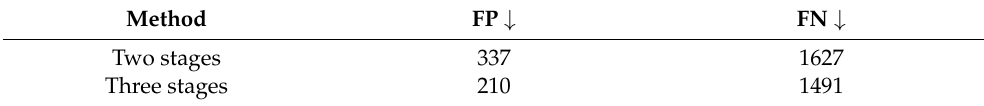
Table 4. Performance comparison for the matching module with different methods.